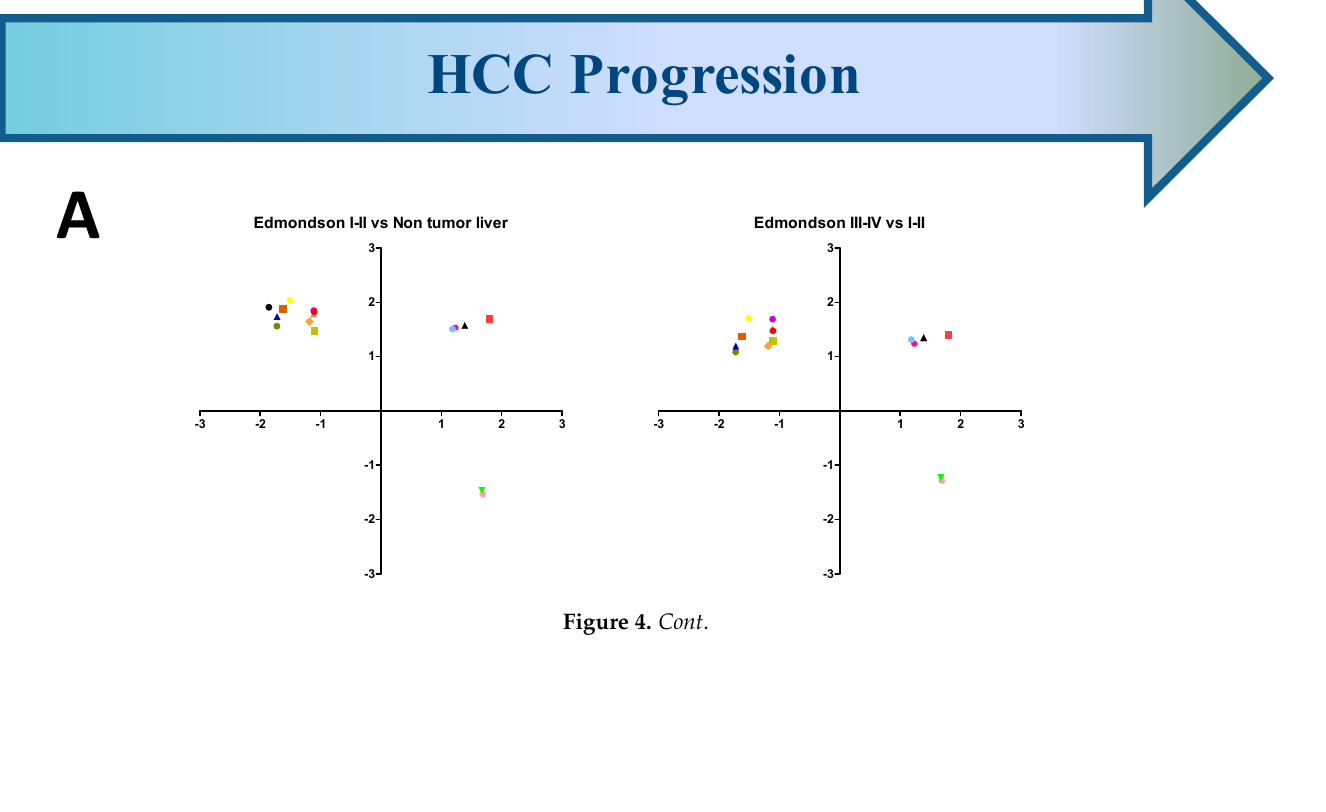
-0.7-0.5-0.3-0.1 Figure 4. Histological signs of HCC are imperfect correlates of AILD associated HCC signatures. ( A ) 2D scatter plots depicting the enrichment scores of transcription factor modules along AILD vs. healthy liver (x axis) and advanced stage vs. previous stage of HCC (y axis) comparisons for different HCC etiology groups. Enrichment scores were obtained fol- lowing GSEA against “TF.Target.ENCODE” database on iDEP.91. Moving rightwards along the x axis indicates increased expression in AILDs and moving upwards along the y axis indicates increased expression in HCC. ( B ) Spearman rank correlation coefficient between AILD and HCC for each stage of Edmondson–Steiner grading. ( C ) kinetics of shift in NES ratio between AILD and HCC for each transcription factor module across all stages of HCC. The color and signs of each transcription factor module (for A , C ) are shown at the right side of ( C ). 3.5. Transcriptomic Signatures of AILD Follow the Fibrotic Patterns on Carcinomatous Livers Autoimmune conditions of the liver result in a robust immune activation, leading to severe hepatic inflammation and fibrosis [39]. Since fibrosis is an important mediator of I - II vs N on t u m o r III - I V vs I - II